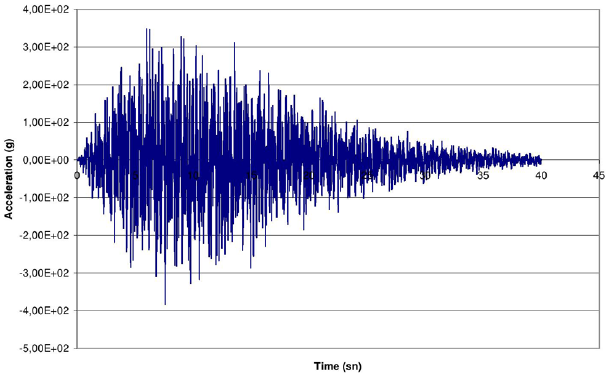
Fig. 16. Synthetic earthquake record obtained by TARSCHTS for the A18 cell (˙Ince, 2005).